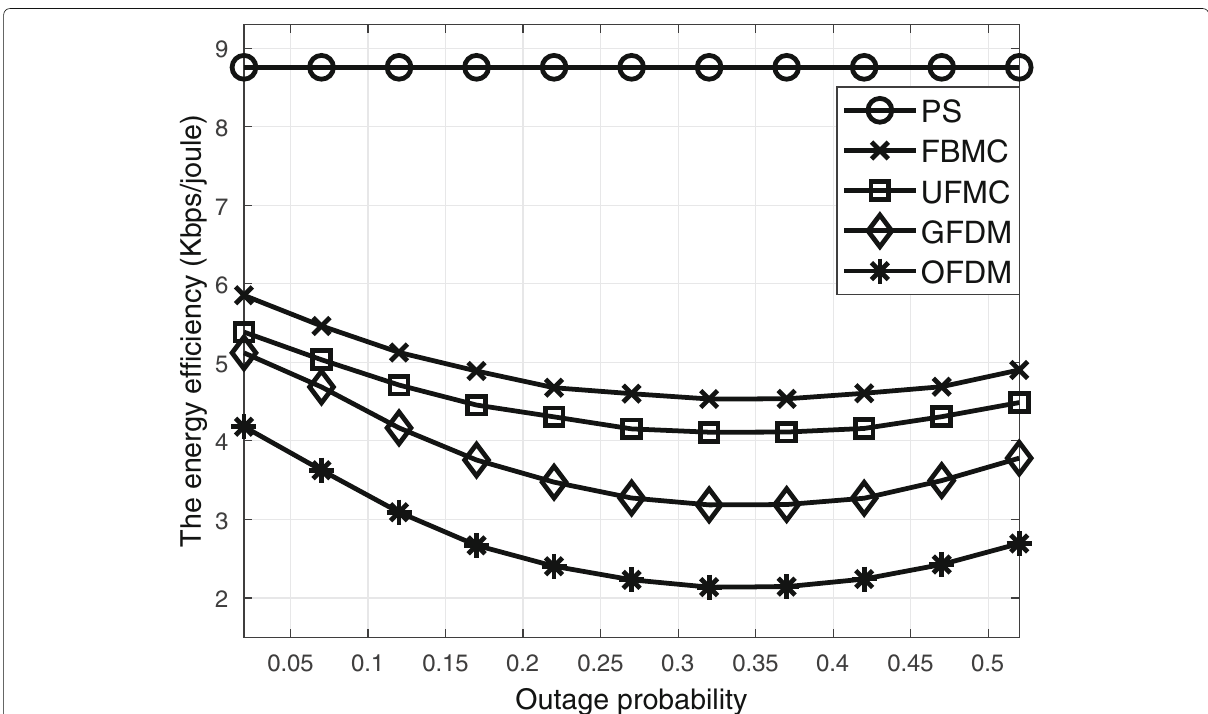
Fig. 9 Energy efficiency versus outage probability. The performance of the proposed algorithm using various modulation schemes versus different outage probability